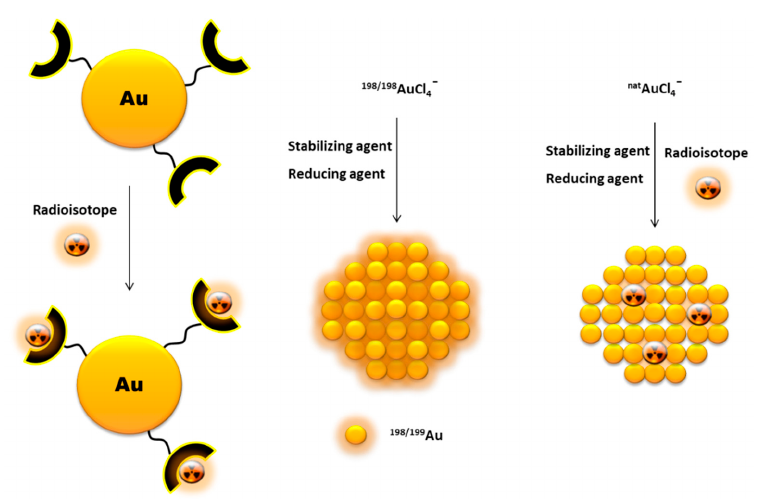
Figure 5. Schematic drawing of different pathways to incorporate radionuclides into AuNPs. In some cases, it is possible to attach other radionuclides to the AuNPs without the need of extra chemical derivatization. This can be achieved by adsorption of the radionuclide to the AuNP surface, namely for 131 I or 64 Cu [59,60]. The incorporation of the radionuclide in the NPs core is another possibility, as reported by Liu et al. for 64 Cu alloyed AuNPs modified with PEG. These 64 Cu-labeled AuNPs were obtained starting from HAuCl 4 and 64 Cu(acac) 2 and using oleylamine as reducing agent [61]. In the same way, Chen et al. have studied the integration of a 64 Cu shell into PEG-stabilized AuNPs by reducing 64 Cu(II) in the presence of hydrazine and polyacrylic acid [62]. 4. Examples of Radiolabeled AuNPs for Nuclear Imaging Applications As summarized in Table 3, many imaging radionuclides were used in the labeling of a variety of AuNPs to evaluate their biological fate in selected cellular and animal models, which included ex-vivo biodistribution studies or nuclear imaging scans (PET or SPECT). Part of this work also involved studies of image-guided drug delivery by AuNPs. In the next sub-sections, the most recent and relevant results are reviewed by the types of radionuclides used, i.e., radiohalogens vs. radiometals. Table 3. Examples of AuNPs labeled with imaging radionuclides and respective preclinical studies. Radioisotope